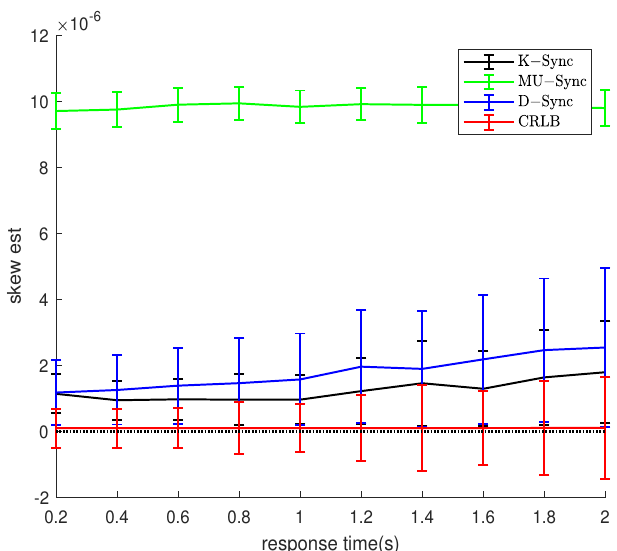
Figure 7. Performance with response time (Model 1).